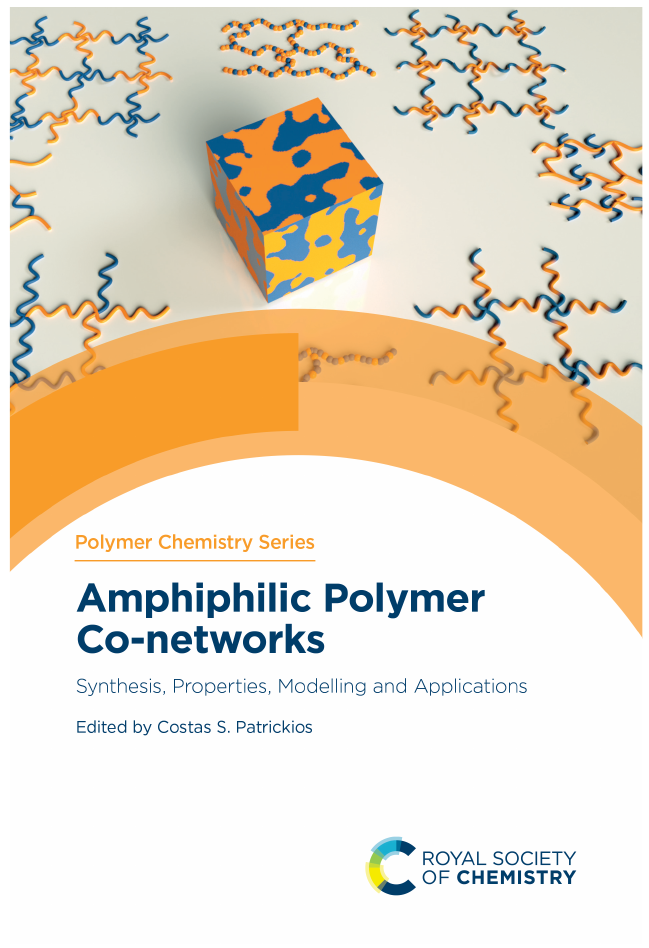
Figure 1. Book Cover, © Royal Society of Chemistry 2020. Other key information: hardcover, 363 pages, £179.00—ISBN